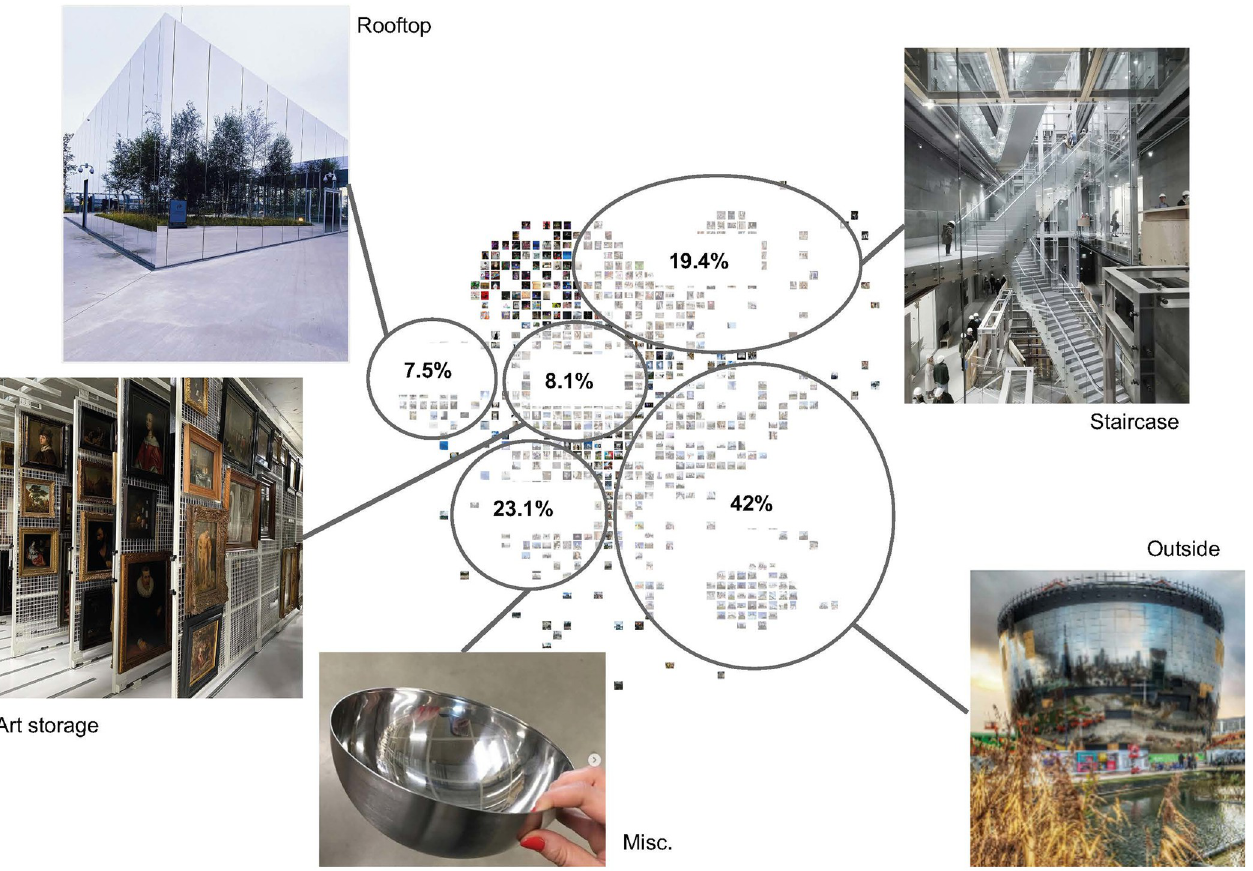
Fig 10. Visualisation of the image clustering (by